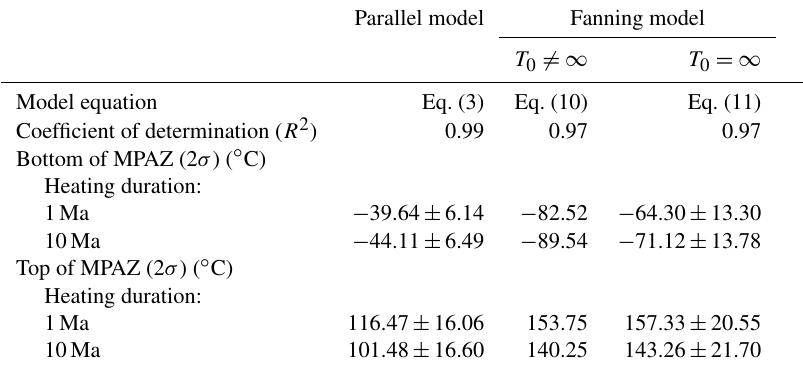
Figure 4. Normalized track length reduction ( l/l 0 ) against temperature for calculated equivalent confined fission tracks in Harcourt gra- nodiorite monazite. The track length reduction values are averaged across both sets of surfaces (// to (100) and ⊥ to the c axis) with the normalized track length ( l/l 0 ) values being calculated from the average length of the unannealed control samples (10.60µm). Table 4. Results of the Arrhenius model-fitting calculations, including estimated temperatures ( ◦ C ± 2 σ error) for the monazite partial annealing zone (MPAZ). Note the T 0 (cid:54)= ∞ estimated MPAZ has no error listed as it is not possible to reliably calculate the confidence